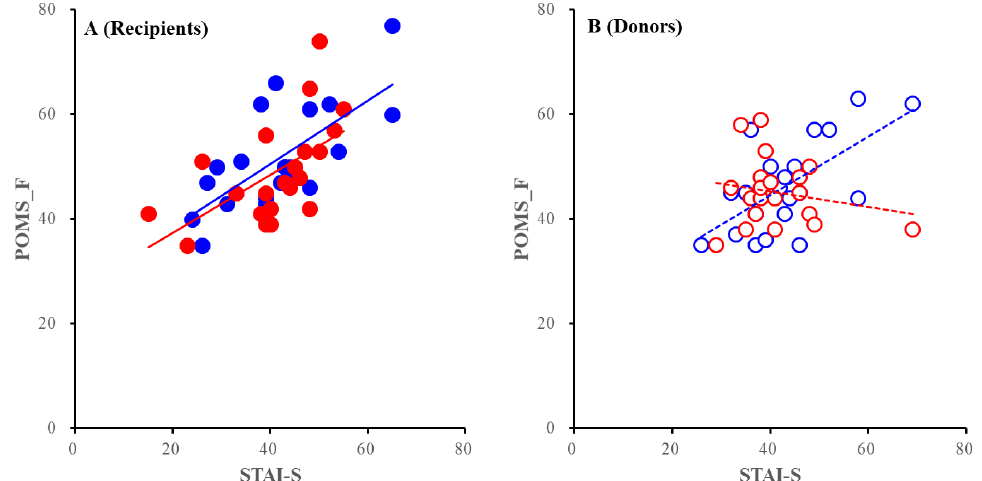
Figure 4. Correlation between the POMS-TA and STAI-T of recipients ( A ) and donors ( B ). Blue and red circles indicate PEKT, and PDKT, respectively. Closed and opened circles indicate recipients and donors, respectively. Full and dotted lines indicate the regressions of recipients and donors, respectively. Ordinates and abscissas indicate the mean ± SD of the POMS-TA, and STAI-T scores, respectively.